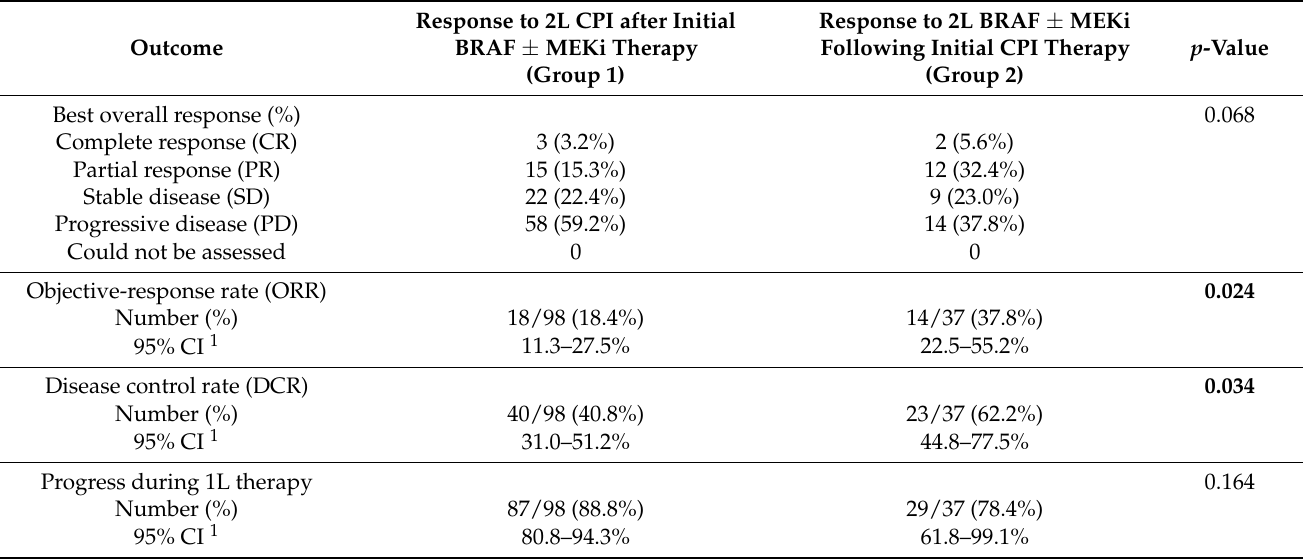
Table 3. Response to second-line treatment in patients with consecutive treatment with CPI and TT stratified by the sequence regimen